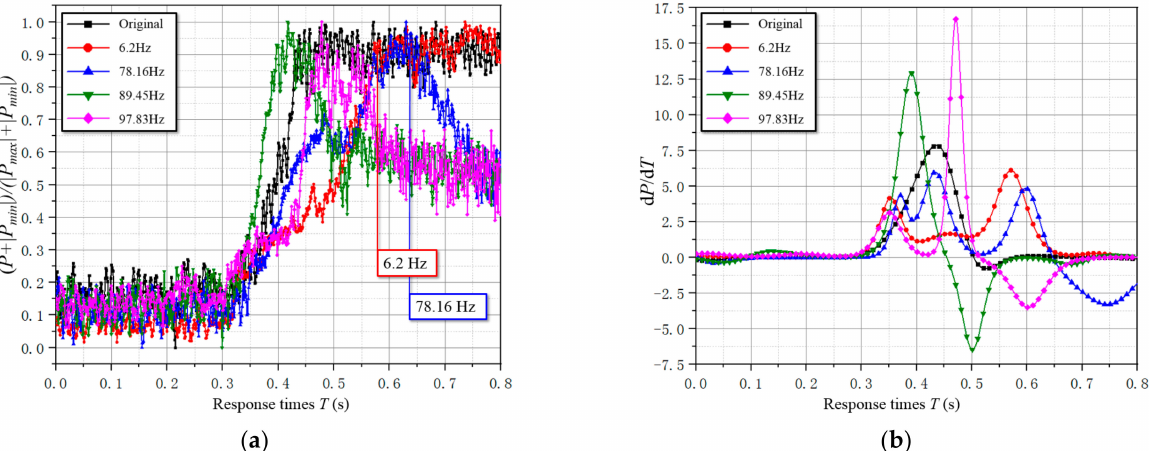
Figure 18. Pressure change curve under the condition of the jet transient detachment process condition. ( a ) Adding mode PSD frequency pulse jet in the separation bubble area; ( b ) pressure differential change curve in the separation bubble